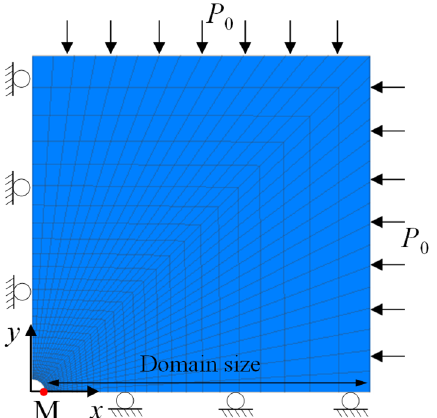
Figure A7. Plane strain numerical model of a cylinder hole in an infinite MC material built with FLAC 3D .